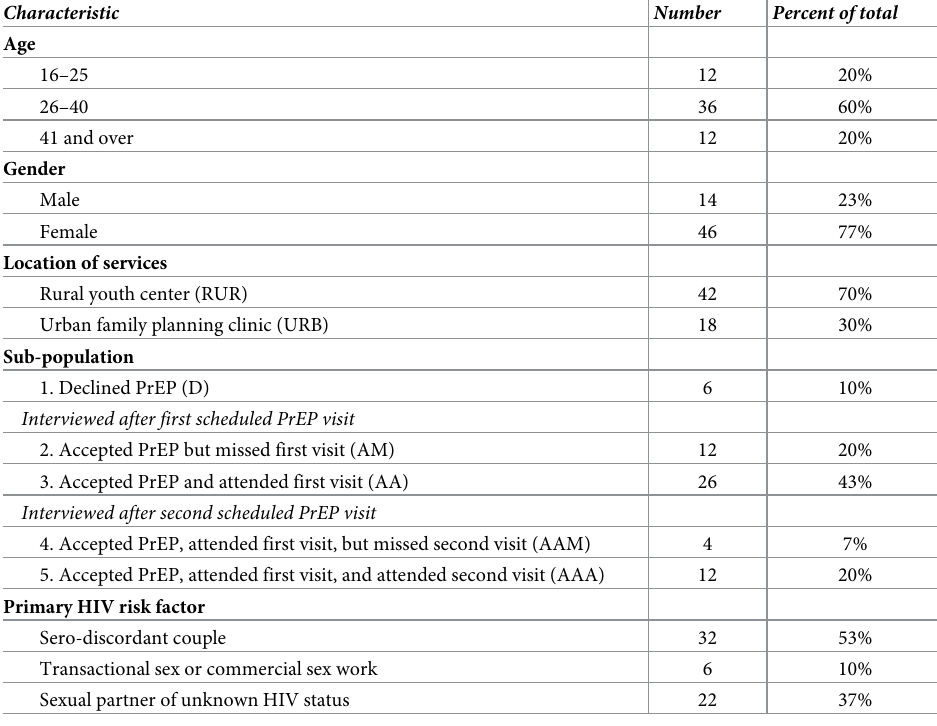
Table 1. Interview participant information 1 .